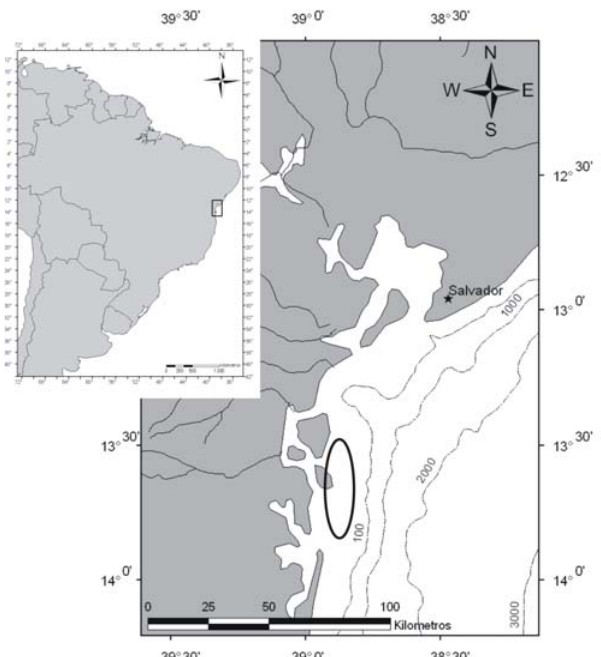
Figure 1. Camamu-Almada region off Bahia state, in northeastern Brazil, including areas of sample